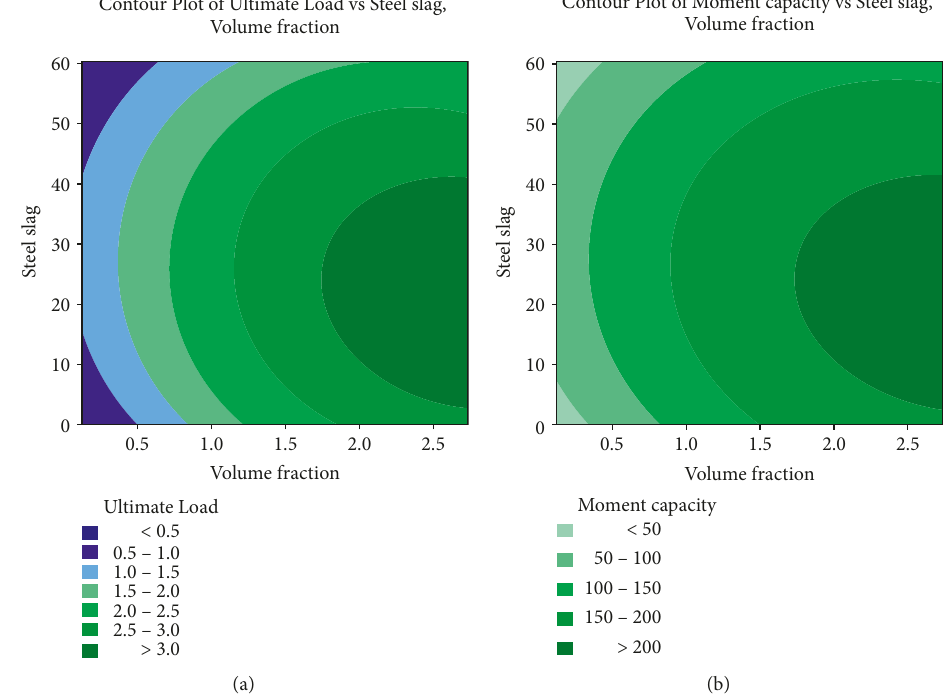
Figure 9: Contour Plot: (a) ultimate load; (b) moment capacity.